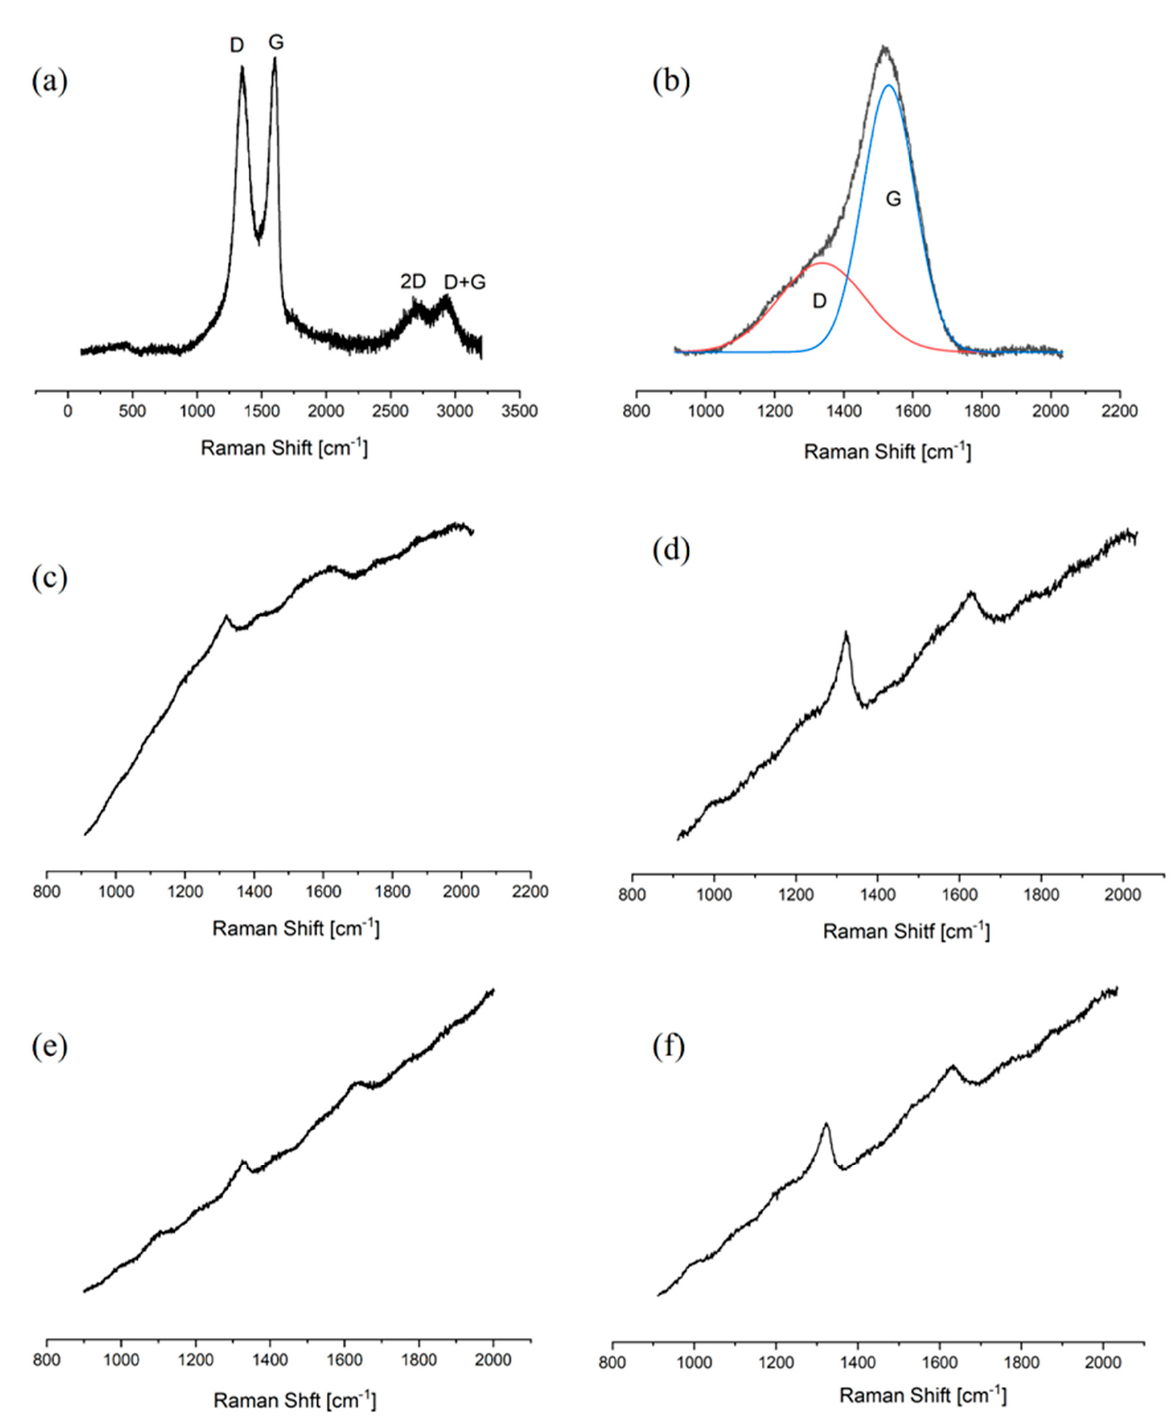
Figure 11. Raman spectroscopy images of Carbon-based Nanomaterials: ( a ) Raman spectrum of graphene oxide film (GO)-ID/IG–2.25; ( b ) Raman spectrum of amorphous carbon powder manufactured by RF PACVD method (RF)-ID/IG–0.55; ( c ) Raman spectrum of fluorescent detonation nanodiamond modified by rhodamine (MDCHF)-ID/IG–2.39; ( d ) Raman spectrum of detonation nanodiamond particles modified by plasma-chemical method (MDP1)–ID/IG–2.24; ( e ) Raman spectrum of detonation nanodiamond particles modified by chemical method with hydroxyl groups (MDCHPOH)–ID/IG–0.63; ( f ) Raman spectrum of detonation nanodiamond particles manufactured by detonation method